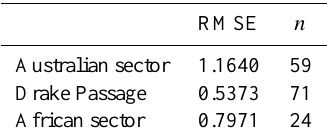
Table 1. Estimated PF location RMS error (degrees of latitude) and sample size ( n ), by